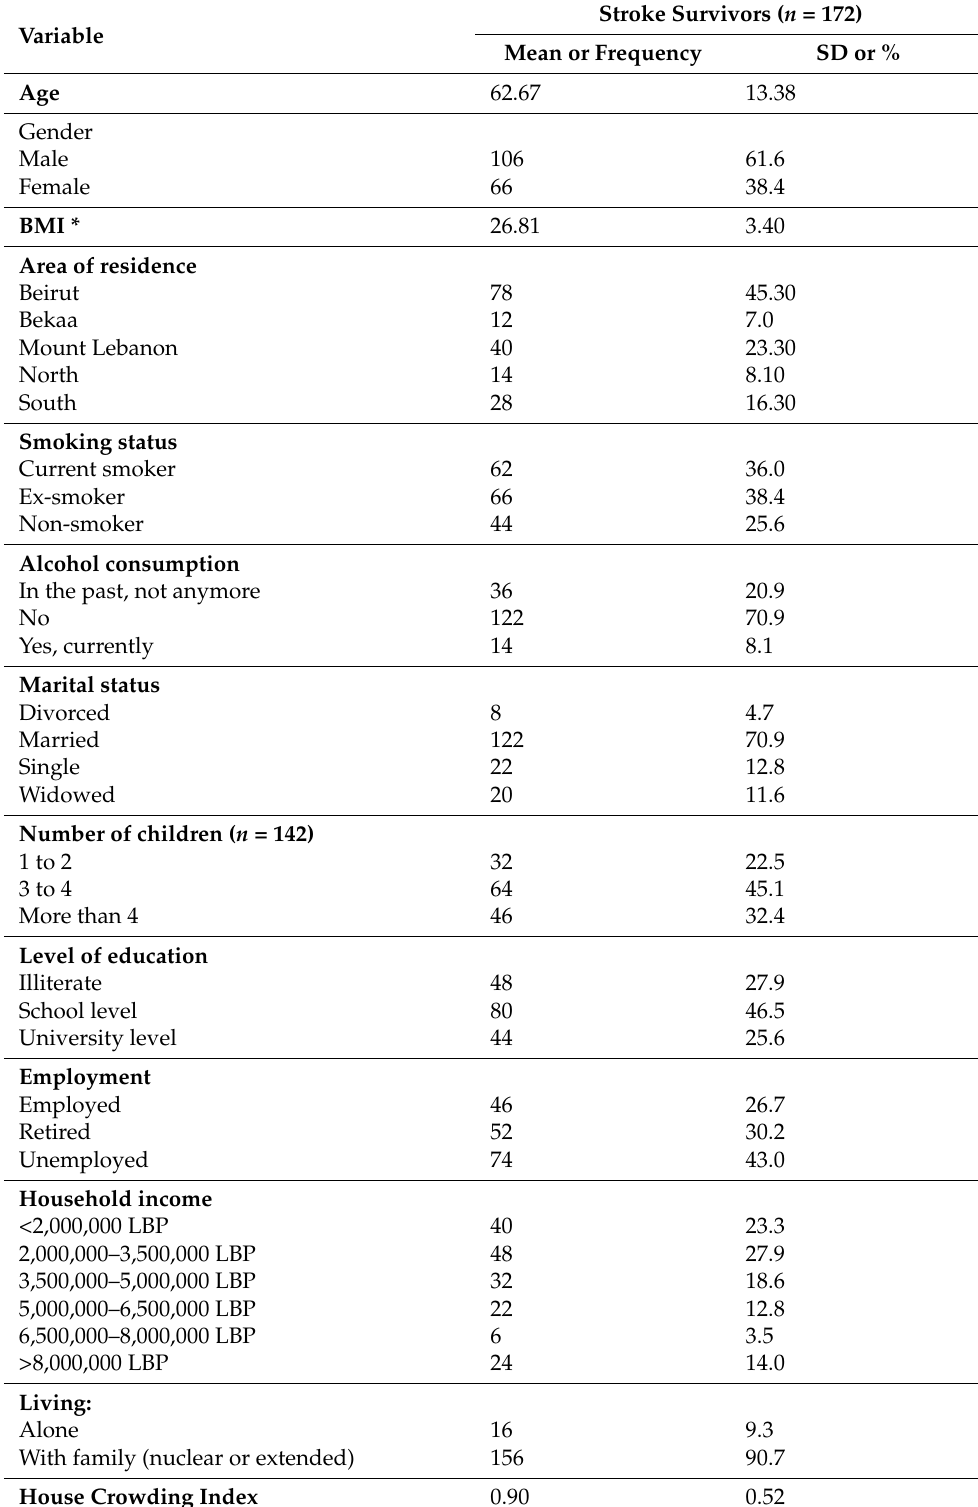
Table 1. Sociodemographic and socioeconomic characteristics of the patients.